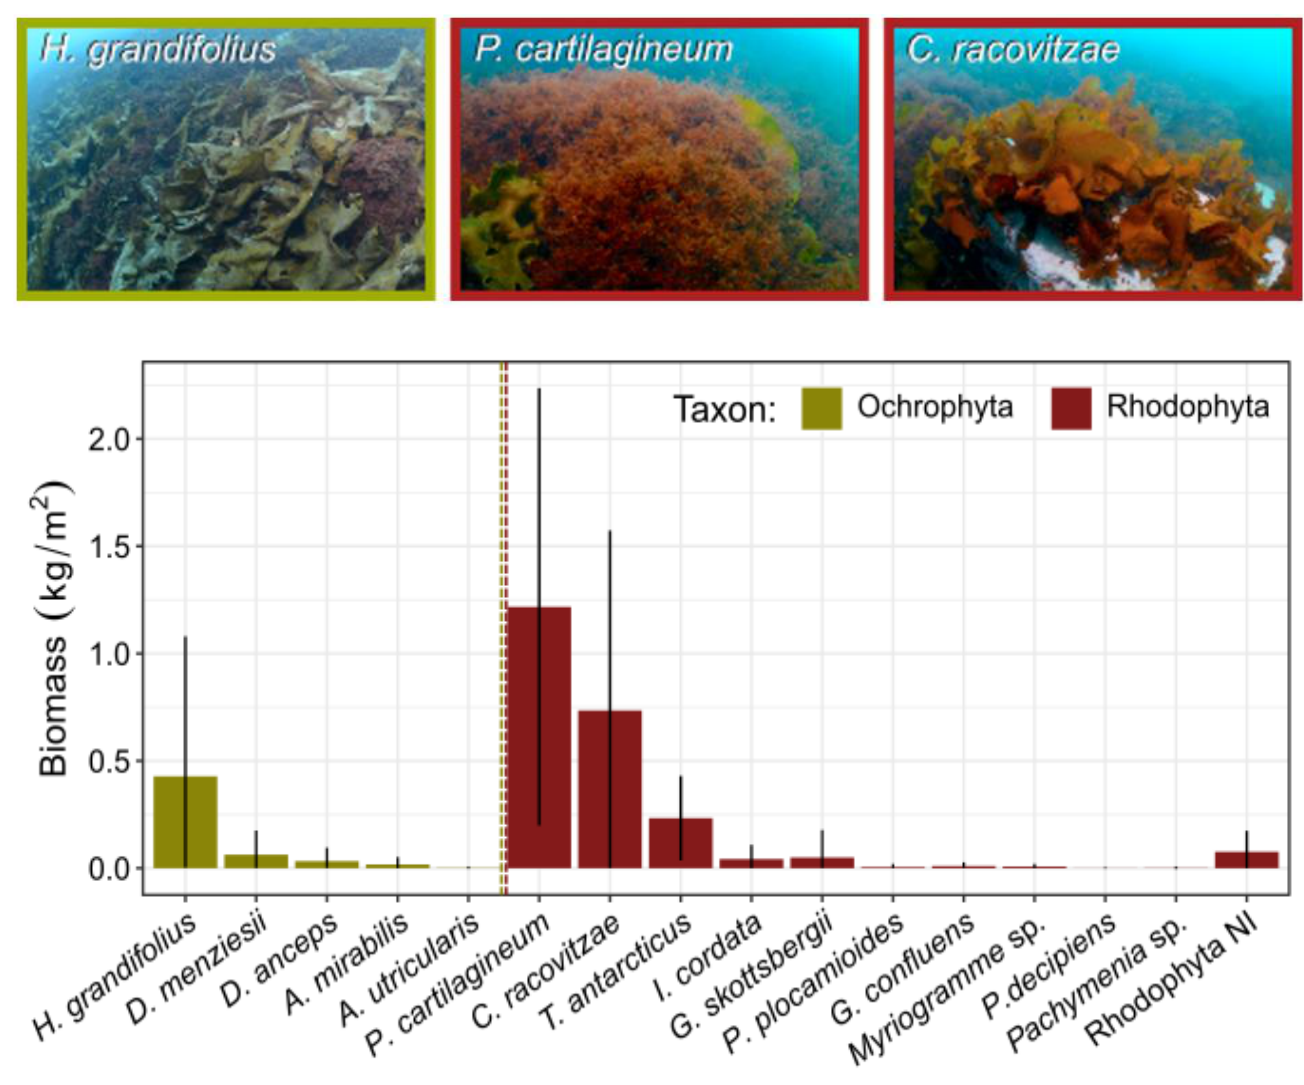
Figure 4. Area-specific biomass (kg/m 2 ) of the 16 algal species observed inside ice pits based on quadrat samples collected from 11 ice pits in 2018. Full species names are provided in Table 3. Species are colored according to higher taxa; error bars represent the standard deviation around mean values. Rhodophyta NI is small, unidentifiable pieces of rhodophyte algae. Photo descriptions: H. grandifolius : a bed of Himantothallus grandifolius in Fildes Bay at a depth of 15 m. P. cartilagineum : an individual clump of the branched red algae Plocamium cartilagineum near Albatros Islet at a depth of 6 m. C. racovitzae : the red alga Curdiaea racovitzae at a depth of 7 m at Albatros islet.